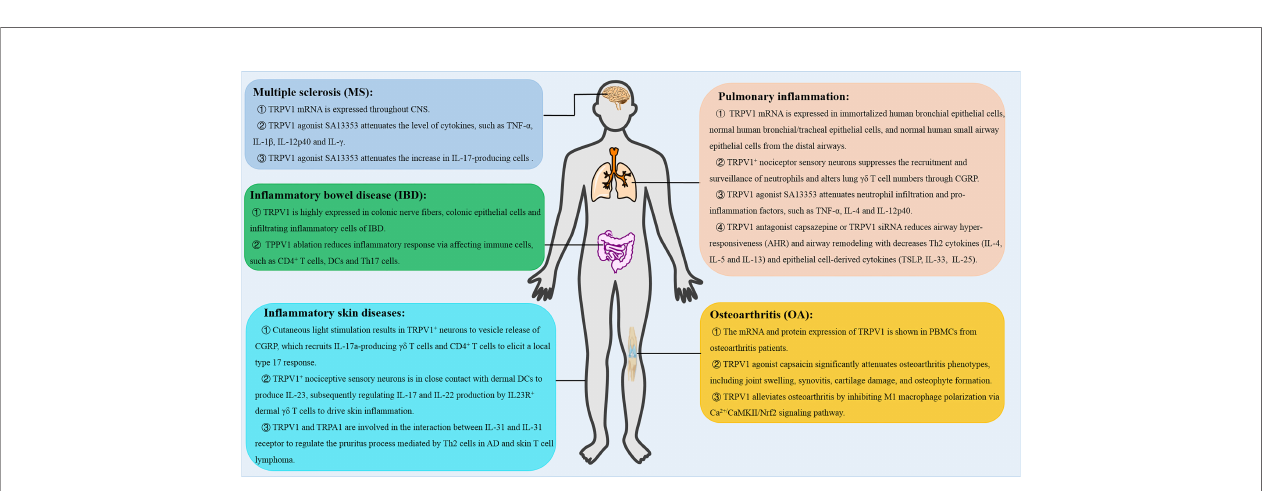
FIGURE 4 | The role of TRPV1 in T cell-mediated in fl ammatory diseases. TRPV1 regulates the in fl ammatory responses, such as multiple sclerosis (MS), pulmonary in fl ammation, in fl ammatory skin diseases and in fl ammatory bowel disease (IBD), and osteoarthritis (OA). CNS, central nervous system; AD, atopic dermatitis; CGRP, calcitonin gene-related peptide.